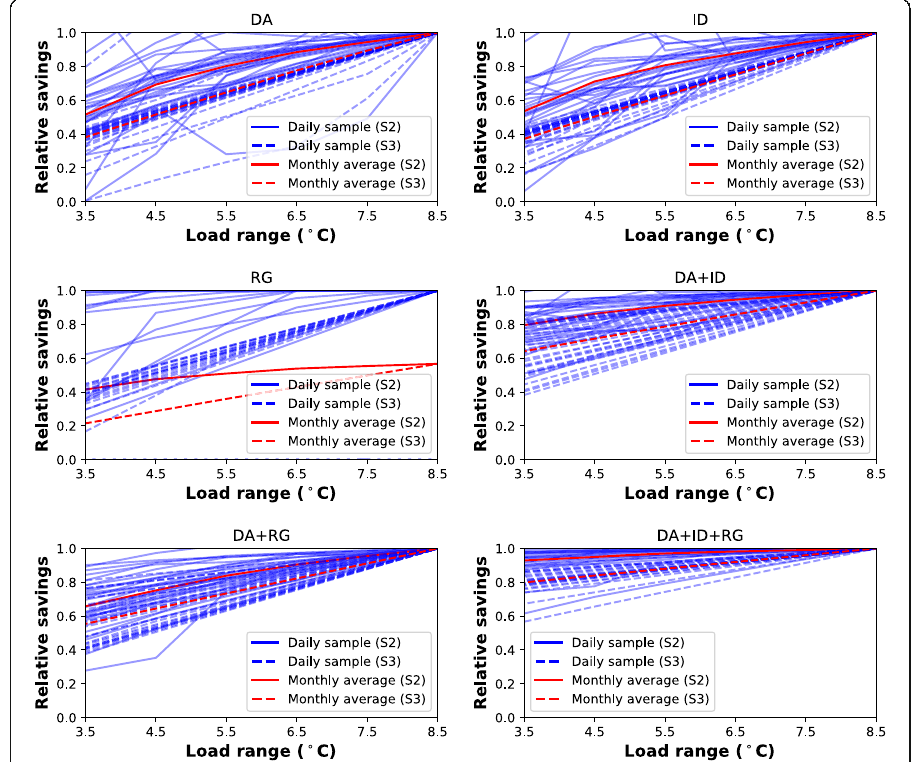
(scenarios 2 and